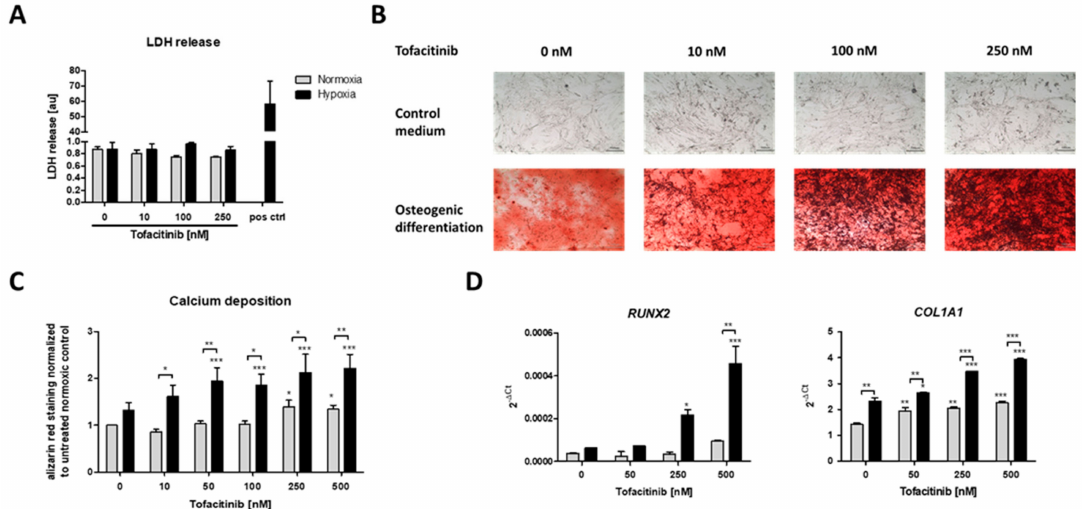
Figure 3. Calcium deposition and osteogenic marker gene expression as markers of osteogenic di ff erentiation were enhanced by increasing doses of tofacitinib only under hypoxia. ( A ) LDH release after 3 weeks, ( B ) calcium deposits (scale bars = 100 µ m) and ( C ) Alizarin Red staining after 3 weeks of osteogenic di ff erentiation ( n = 6; * p < 0.05, ** p < 0.01, *** p < 0.001; two-way ANOVA with Bonferroni post hoc test; asterisks above columns indicate comparison to the respective untreated control = 0 nM tofacitinib). ( D ) Osteogenic marker gene expression for RUNX2 and COL1A1 after 1 week of osteogenic di ff erentiation ( n = 3; * p < 0.05, ** p < 0.01, *** p < 0.001; two-way ANOVA with Bonferroni post hoc